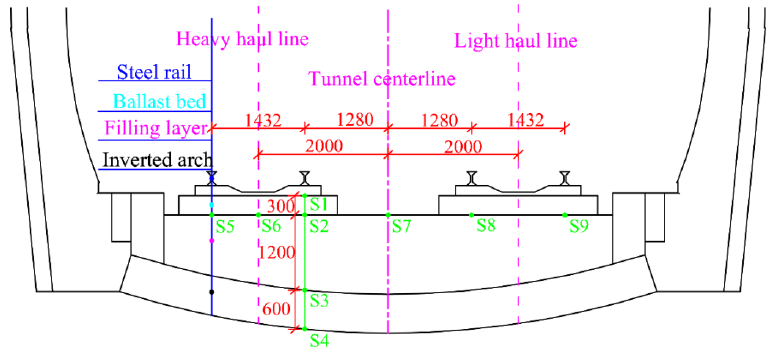
Figure 3. Schematic diagram of field test monitoring points (units: mm).